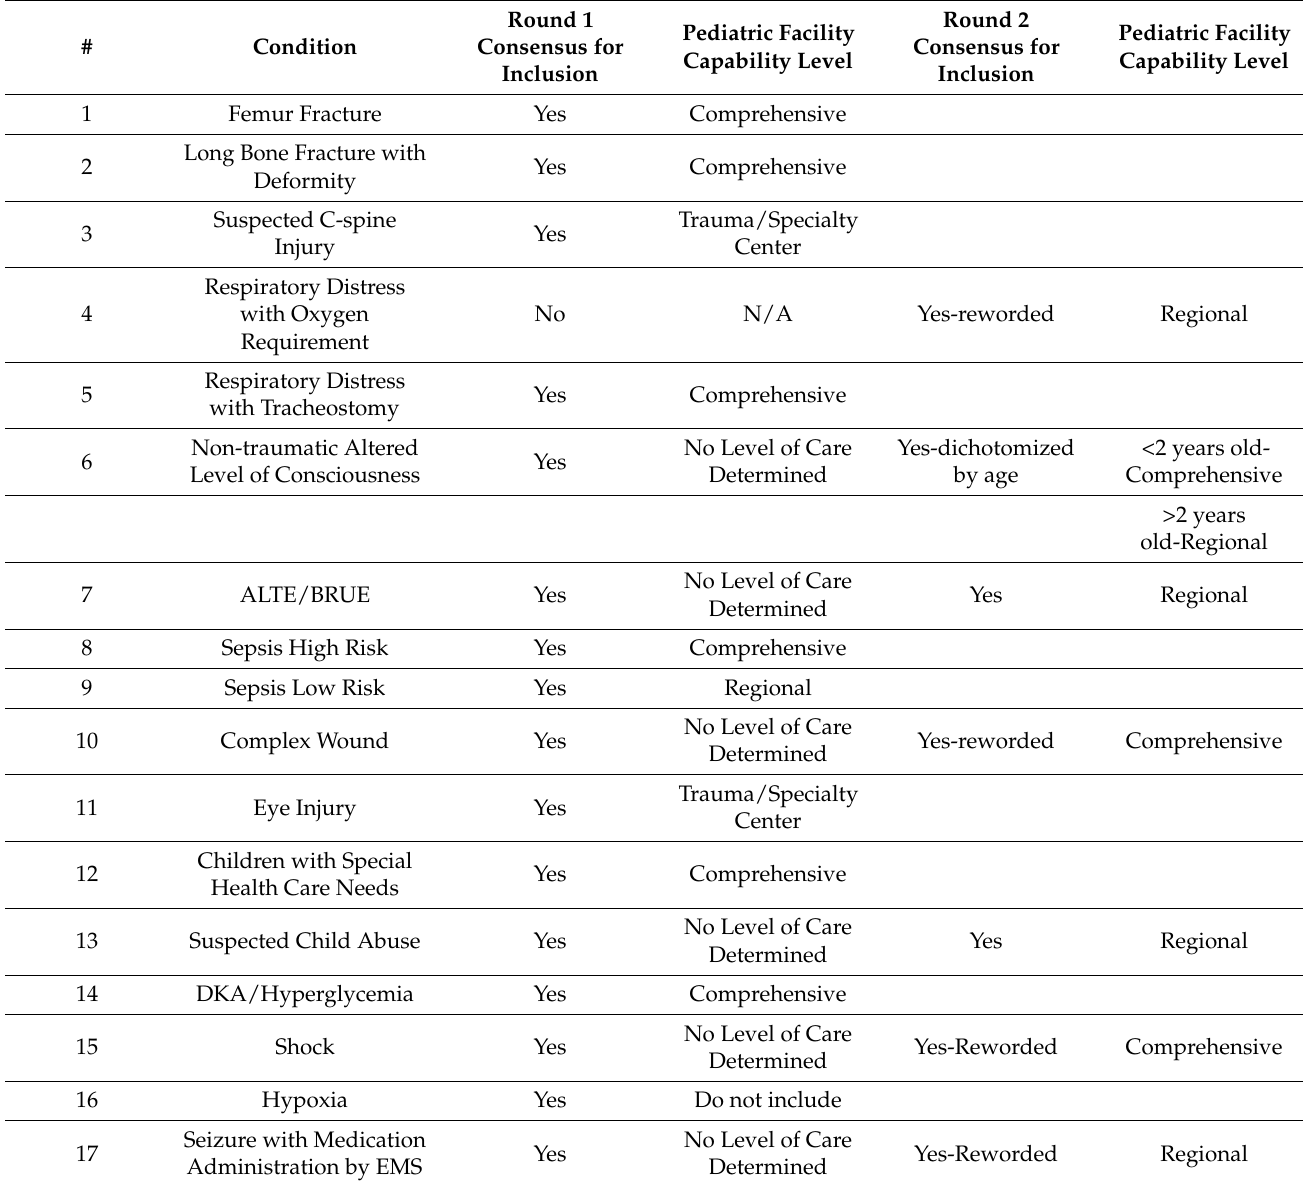
Table 3. Conditions discussed by PDTree EP and voting results by rounds for inclusion on the PDTree and recommended destination-facility capability